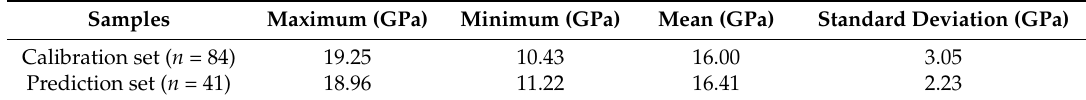
Table 2. Statistics of the Compressive Strength from the Calibration and Prediction Sets.